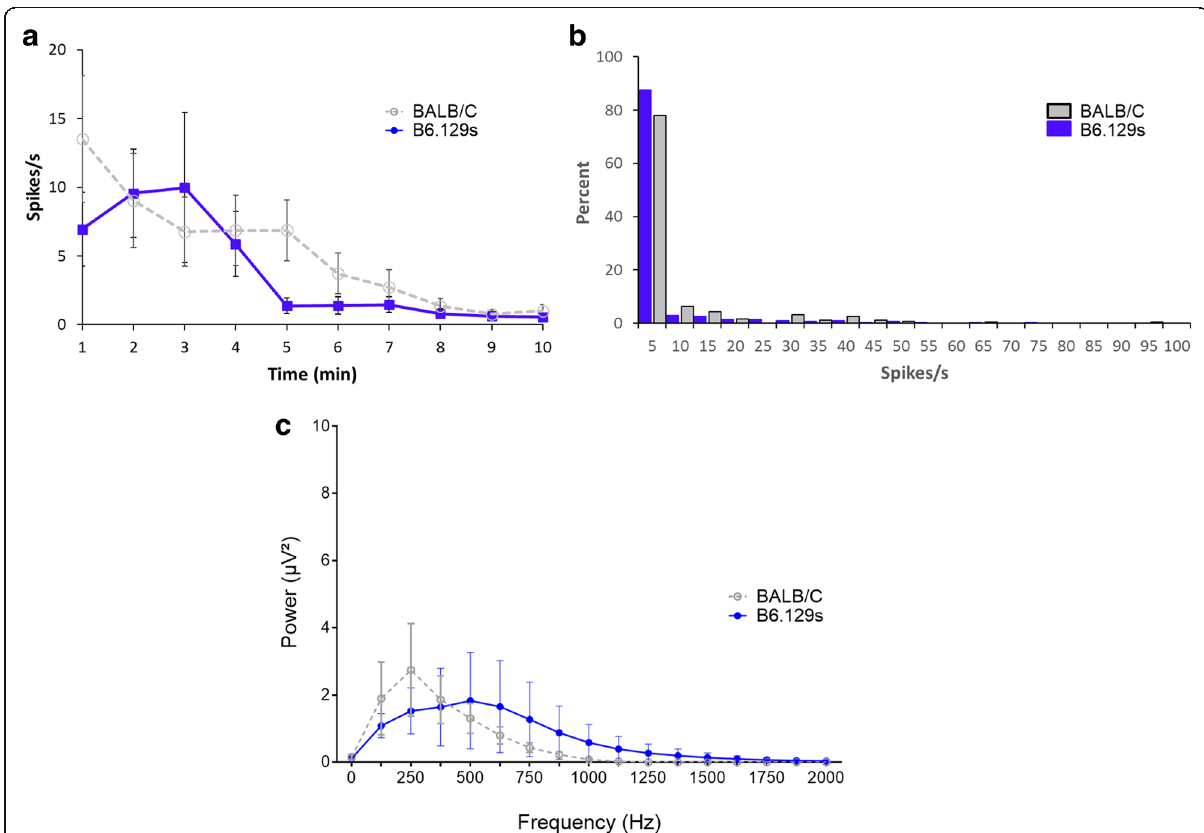
Fig. 6 Baseline vagus nerve activity is comparable between different mouse strains. Baseline vagus nerve activity was recorded in C57BL/6.129S ( n = 31) and Balb/c mice ( n = 25) with a cuff electrode. a Spikes rate of the neural events recorded. b Rate distribution in 1 min segments over 10-min recording. c FFT analysis of the 10 min recordings. No significant difference between different mouse strains was observed (two-way ANOVA, p =